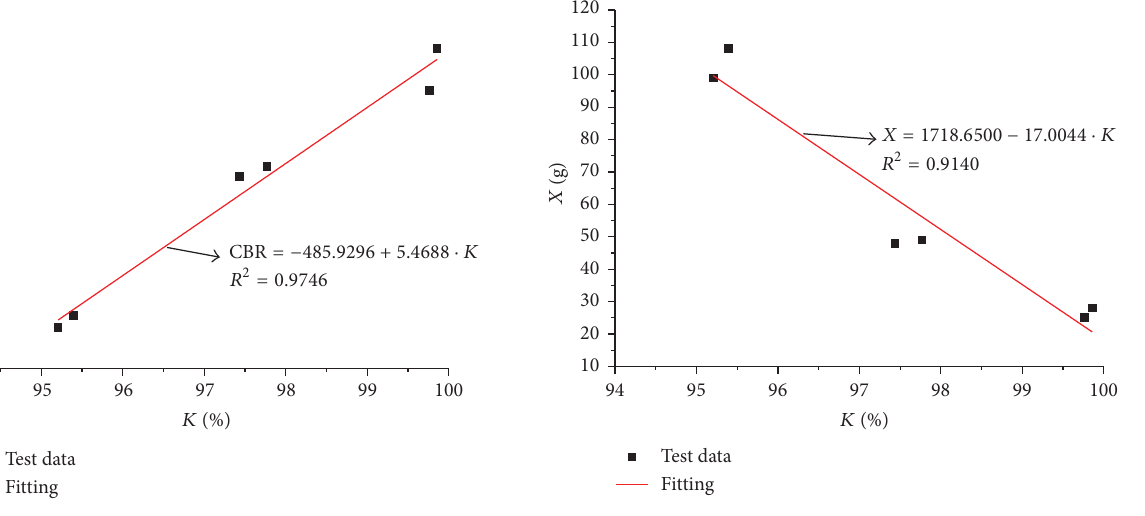
Figure 8: Relation between CBR and compaction degree K.